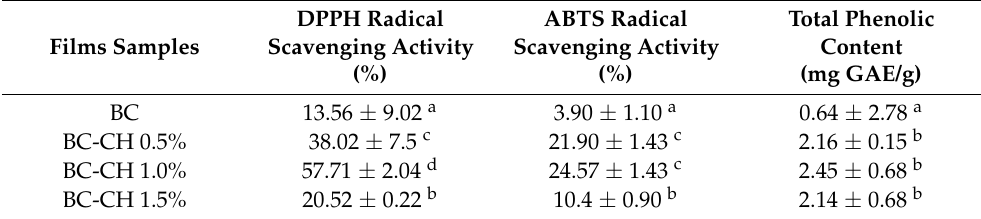
Table 2. Antioxidant activity and total phenolic content of BC and BC-CH films coated with various concentrations of